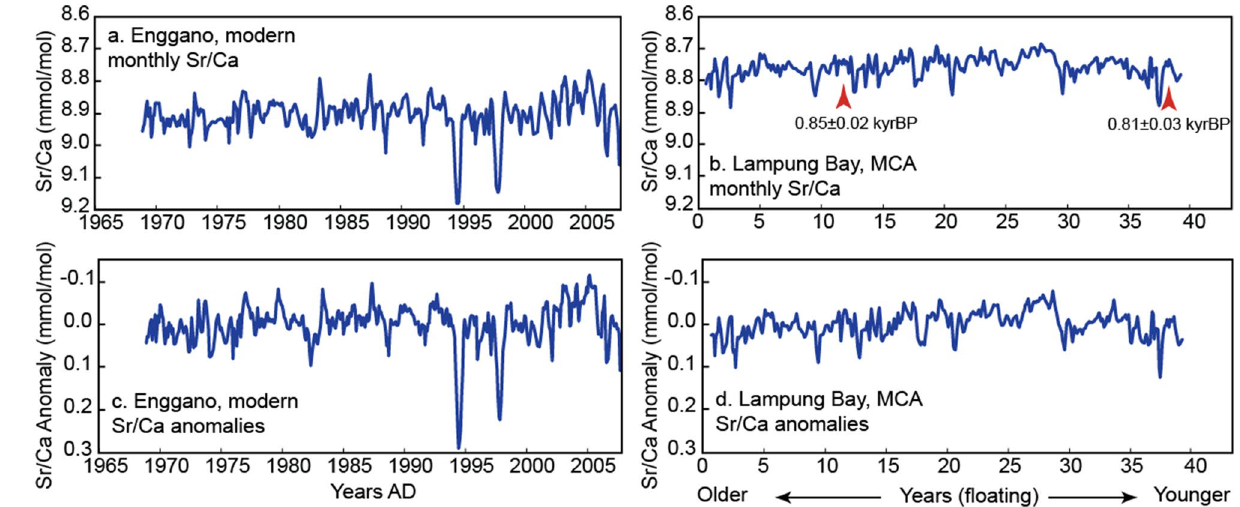
Figure 3. Modern and MCA coral Sr/Ca time series. ( a ) Monthly coral Sr/Ca record of the modern coral from Enggano Island (KN2). ( b ) Monthly coral Sr/Ca record of the MCA coral from Lampung Bay. Red arrows mark the U/Th dates. ( c ) Monthly anomalies of the modern coral from Enggano Island. ( d ) Same as ( c ) but for the MCA coral from Lampung